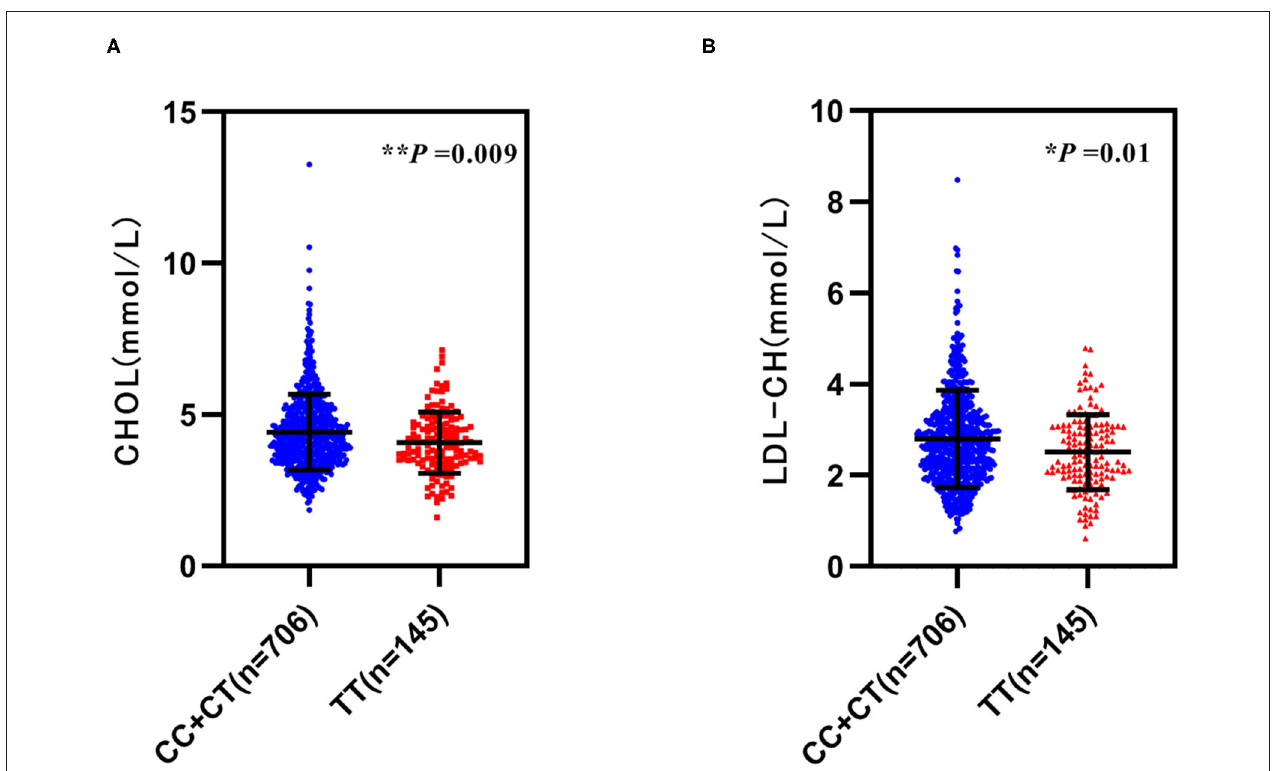
FIGURE 2 | The relationship between GRB10 rs1800504 gene polymorphism and blood lipid levels inpatients with T2DM. (A,B) The levels of cholesterol (CHOL) and low-density lipoprotein (LDL-CH) in a recessive model of rs1800504. Significant differences between groups are indicated by * p < 0.05 and ** p < 0.01.